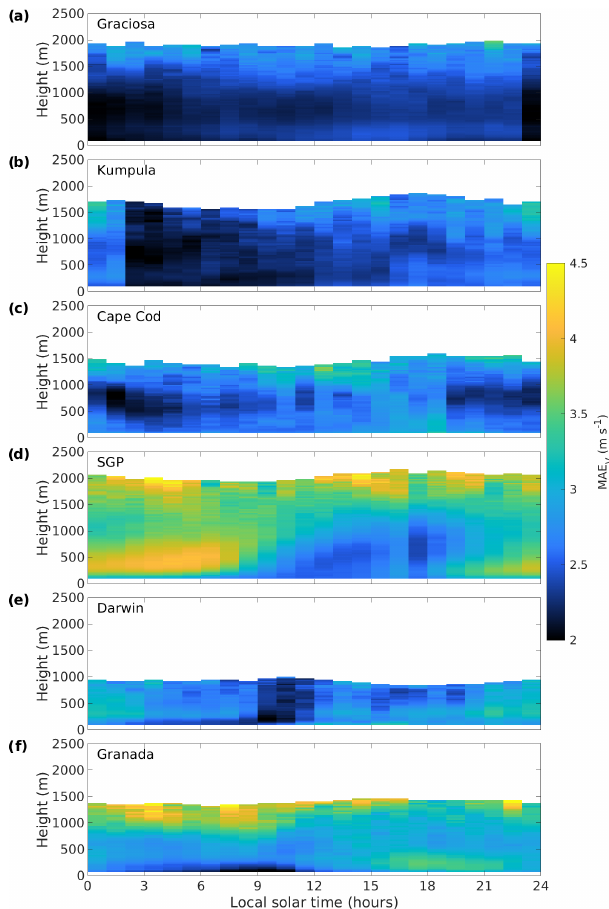
Figure 7. Diurnal composites of mean absolute wind vector error at (a) Graciosa, (b) Kumpula, (c) Cape Cod, (d) SGP, (e) Darwin, and (f) Granada. Time refers to approximate local solar